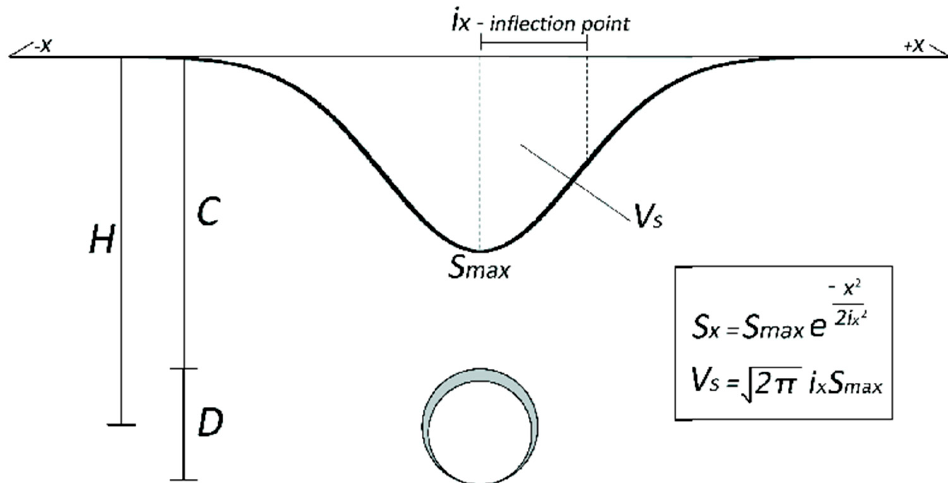
Figure 3. Typical tunnel settlement problem.